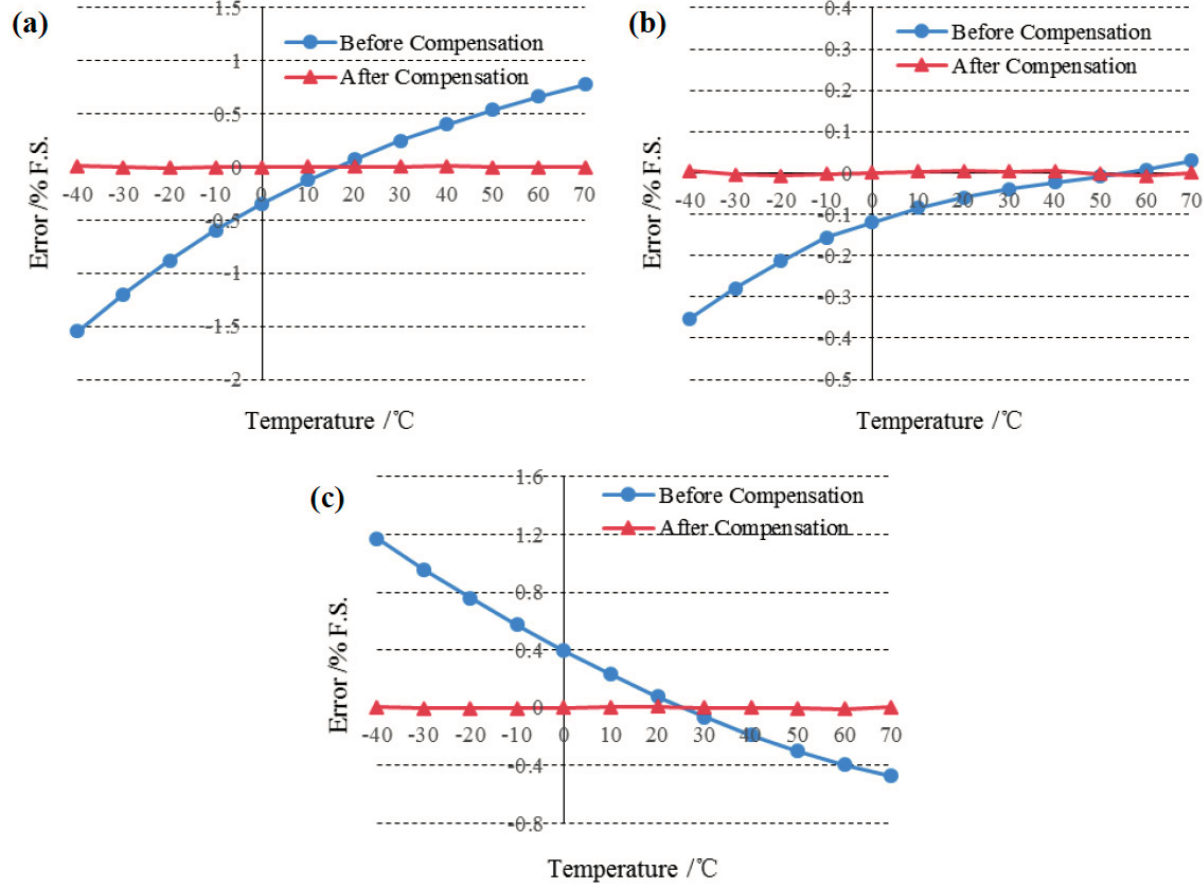
Figure 6. Comparison of the errors before and after compensation at the pressure of ( a ) 50 kPa; ( b ) 80 kPa and ( c ) 110 kPa. Before compensation, the max error was higher than 1.5% while after compensation, the errors were lower than